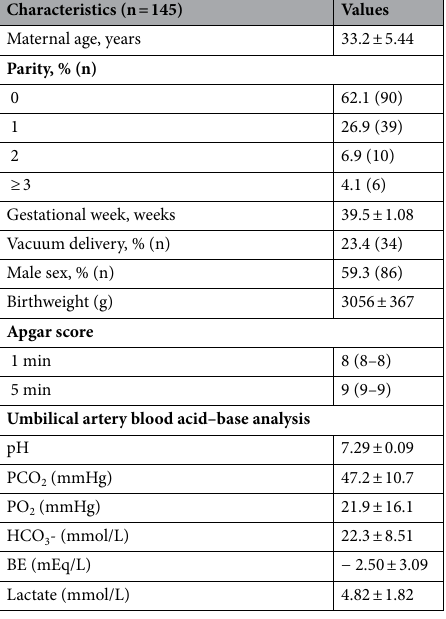
Table 1. Baseline characteristics of the study participants. Data were expressed as mean ± standard deviation, median (25–75%) or n (%). BE base excess, HCO 3 - bicarbonate, PO 2 partial pressure of oxygen, PCO 2 partial pressure of carbon